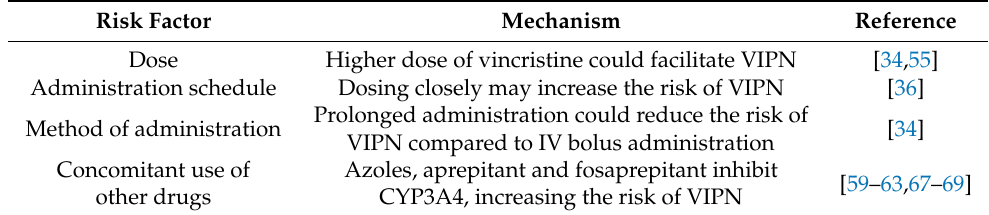
Table 1. Treatment-related risk factors for VIPN in